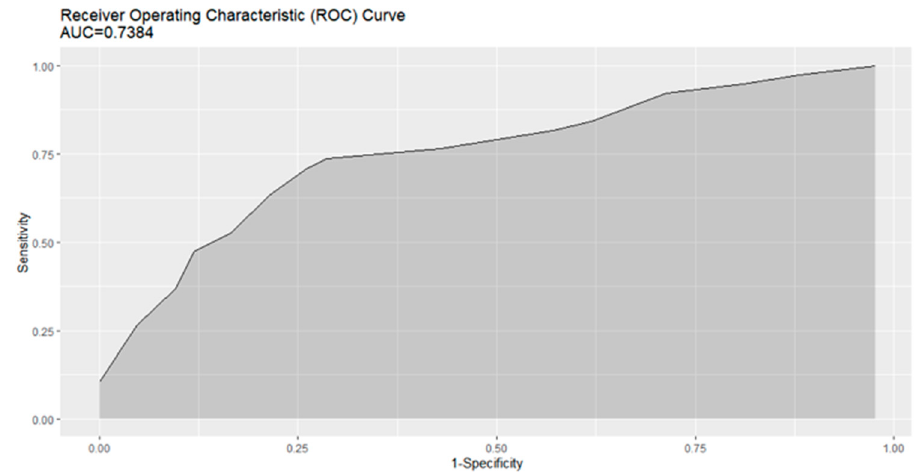
Figure 2. Receiver-operator curve with confidence intervals of the SMSGOP for predicting moderate to severe type of Graves’ orbitopathy in patients with Graves’ hyperthyroidism. SMSGOP; The Score for Moderate to Severe type of Graves’ Orbitopathy Risk Prediction.